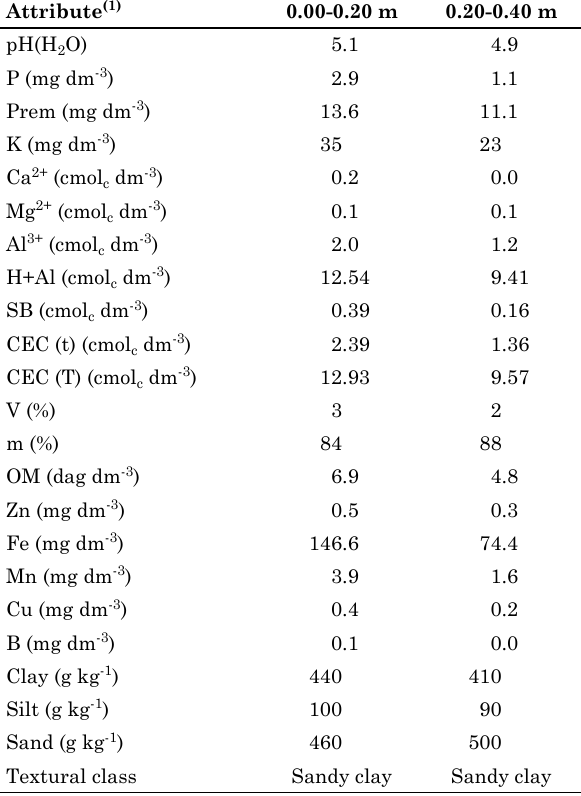
table 1. Physical and chemical analysis of the soil in the experimental area, evaluating five N and K rates and three macaw genotypes, at the Experimental station of araponga,